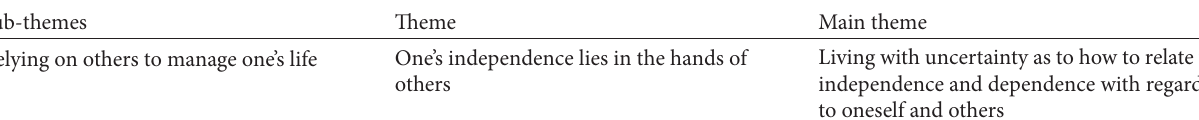
Table 2: Subthemes, themes, and main